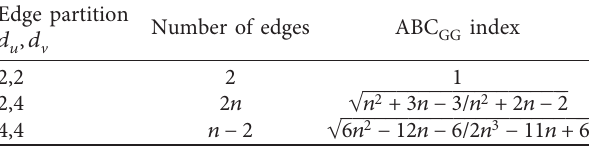
Table 2: Edge partition of oxide network of n order. Edge partition d u , d v Number of edges